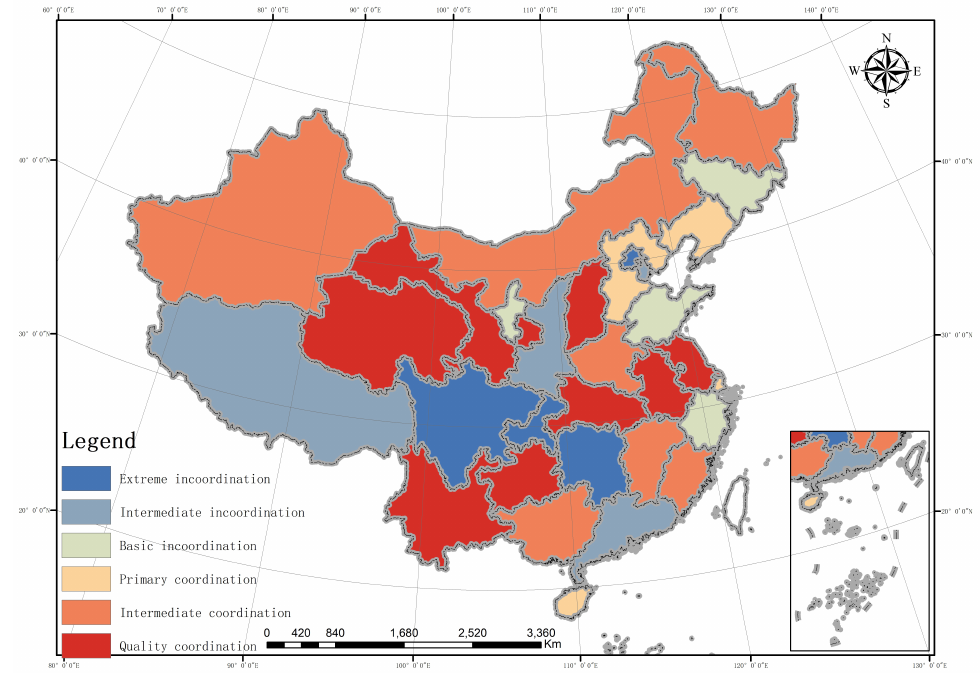
Figure 6. Level of coordination of sports tourism in various provinces in China. The color in the picture changes from blue to red: the redder the color, the more coordinated the development of sports tourism. See the legend for